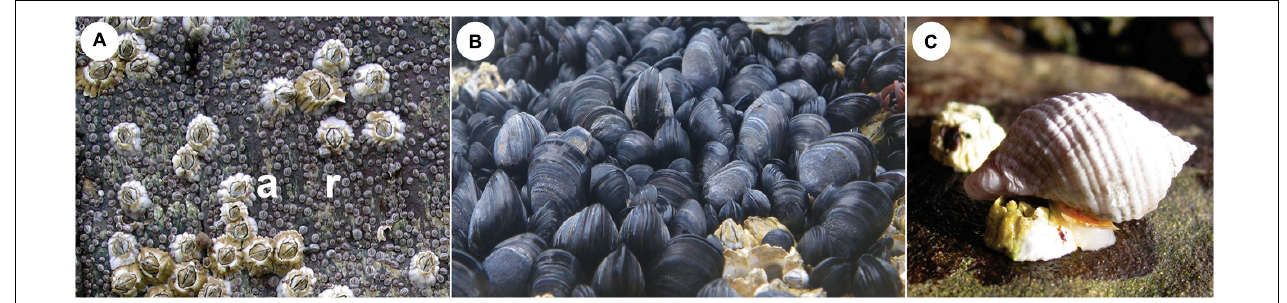
FIGURE 1 | (A) Barnacles ( Semibalanus balanoides ), including (a) adults and (r) recruits (recruits being 1–2 mm in shell diameter), (B) blue mussels ( Mytilus spp.; shell length of up to a few cm), and (C) dogwhelk ( Nucella lapillus ; shell length typically of up to a few cm) from rocky intertidal habitats on the Nova Scotia coast,